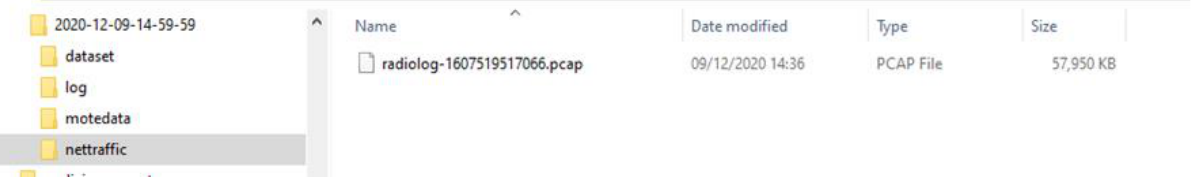
Figure 32. The “nettraffic” folder inside the root folder “2020 -12-09-14-59- 59” and the copy of the “radi olog- 1607519517066.p cap” file .